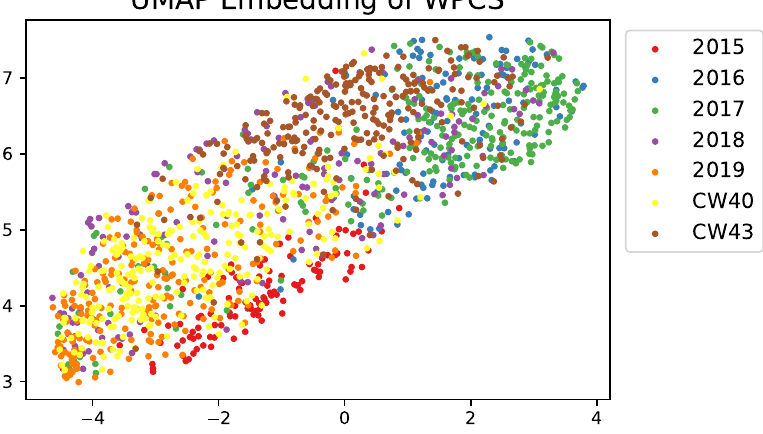
Figure 10. UMAP embeddings of various RGB images captured during different